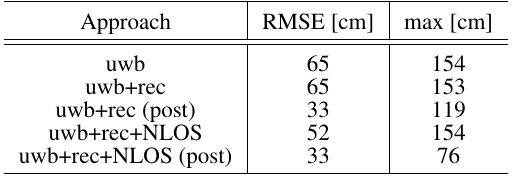
Table 1. 2D positioning performance comparison to